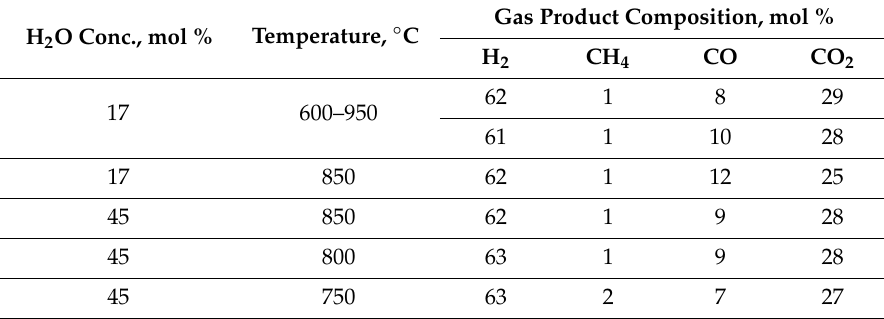
Table 2. The calculated composition of gases using the procedure presented in [28,29]. H 2 O Conc., mol